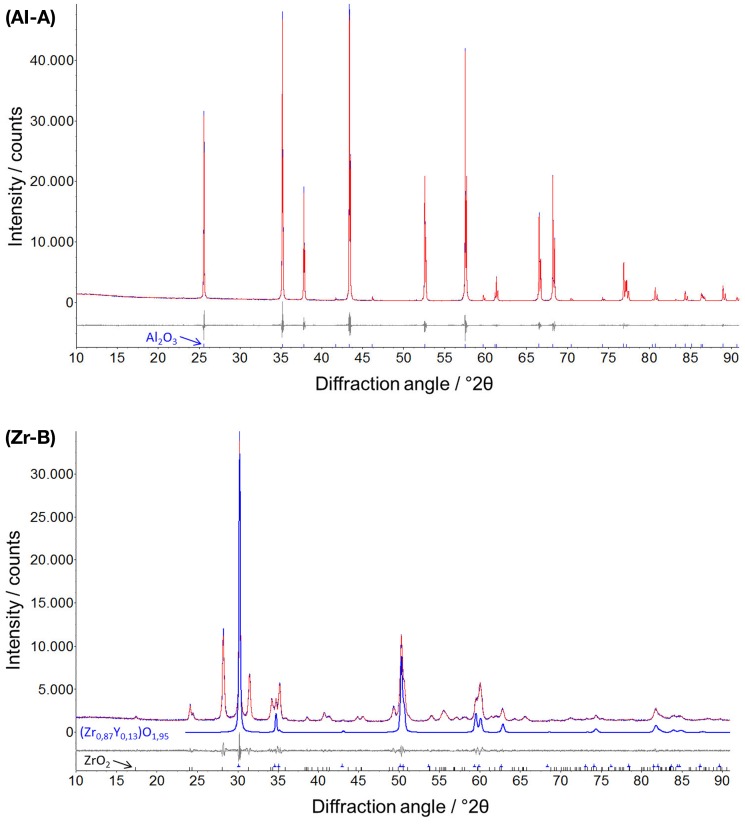
Representative X-ray powder diffractograms of alumina (Al-A, Rwp = 5.5) and yttria-stabilized zirconia (Zr-B, Rwp = 3.5) with additionally denoted rhombohedral Al2O3 (corundum) and tetragonal Zr0.87Y0.13O1.95 phases. Profile and difference plots from Rietveld refinement are shown.